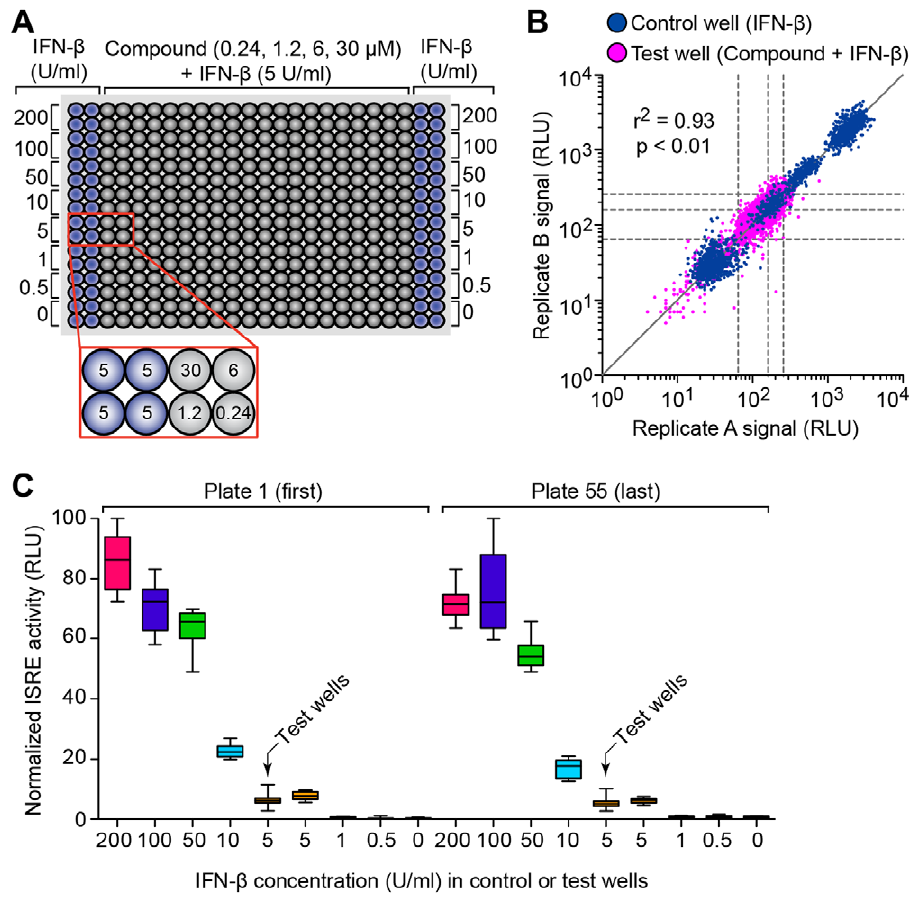
Figure 3. Reproducible and stable signals from HTS of the chemical library. (A) Schematic of assay plate map used in screening the chemical compound library. (B) Reproducibility of raw data between duplicate assay plates for control wells containing IFN- b (0–200 U/ml) and test wells containing compound plus IFN- b (5 U/ml). Dashed lines indicate median 6 SD of each data set from the test wells. (C) Signal consistency through a full screen of 56 assay plates. Values represent replicate A of assay plate 1 (the first plate) and plate 55 (the last plate). Box plots represent median and 25 th and 75 th percentile, and whiskers indicate minimum and maximum of data. Arrows indicate values from test wells. doi:10.1371/journal.pone.0036594.g003 PLoS ONE |